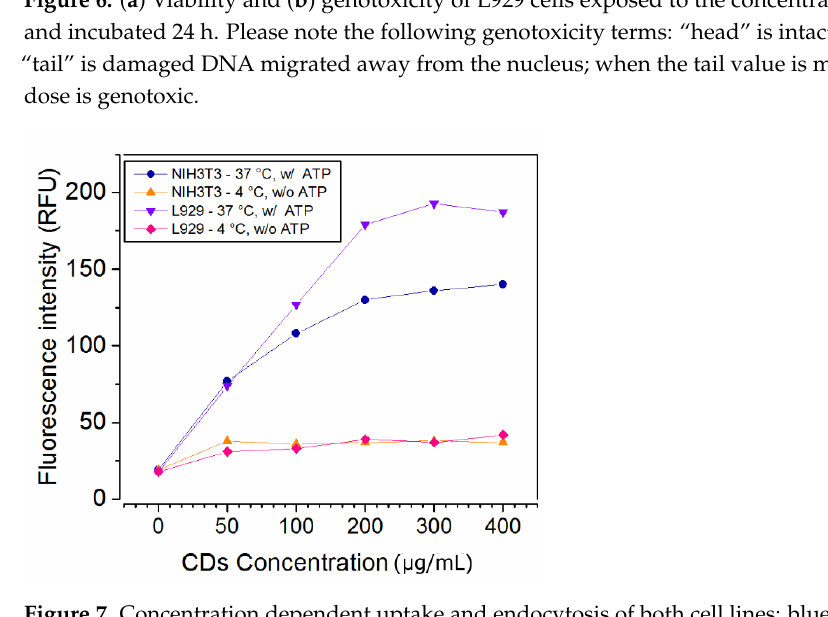
Figure 7. Concentration dependent uptake and endocytosis of both cell lines: blue and violet lines—NIH/3T3, L929 cells incubated in standard conditions; orange and pink lines—NIH/3T3, L929 cells labeled after inhibition of endocytosis.